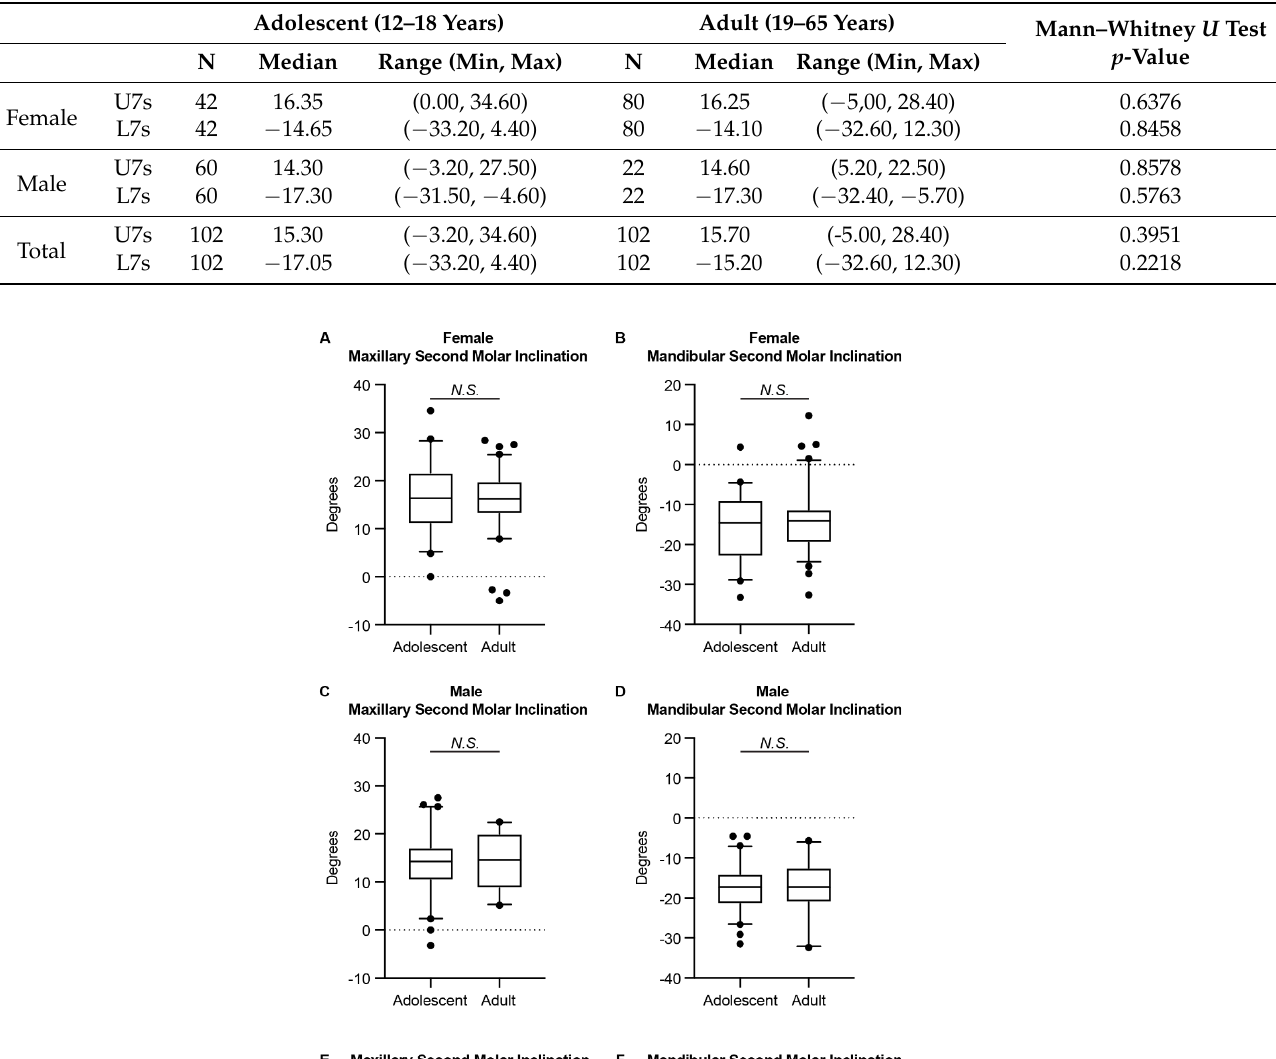
Table 3. The comparison of the second molar inclination between age groups. U7s: maxillary second molars; L7s: mandibular second molars.